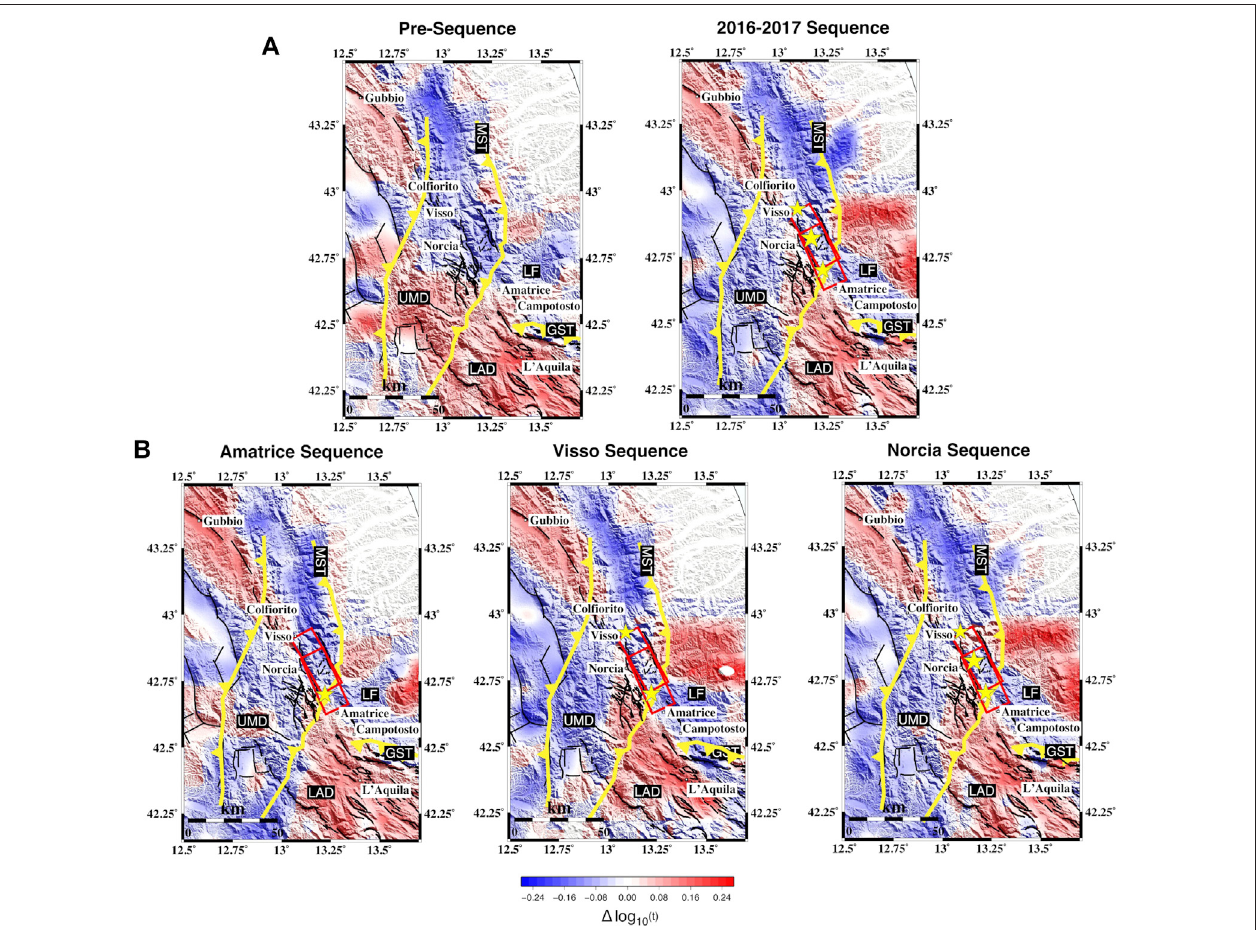
FIGURE6| Spatialandtemporalvariationofpeakdelayatf c =1.5 Hzoverthe (A) pre-sequenceand2016 – 2017sequenceand (B) threeindividualsequencetime frames.RedboxesarethefaultplanefortheAmatriceandNorciaearthquakes,and blacklinesarethefaults fromtheITHACAcatalog.Yellowlines arethemainthrustof the area. The stars indicate the mainshocks of each 2016 – 2017 sequence. The maps have been restricted to the area of interest. The main geological features are highlighted: LF, Laga Formation; UMD, Umbria – Marche domain; LAD, Lazio – Abruzzi domain; MST, Monti Sibillini thrust; GST, Gran Sasso thrust.